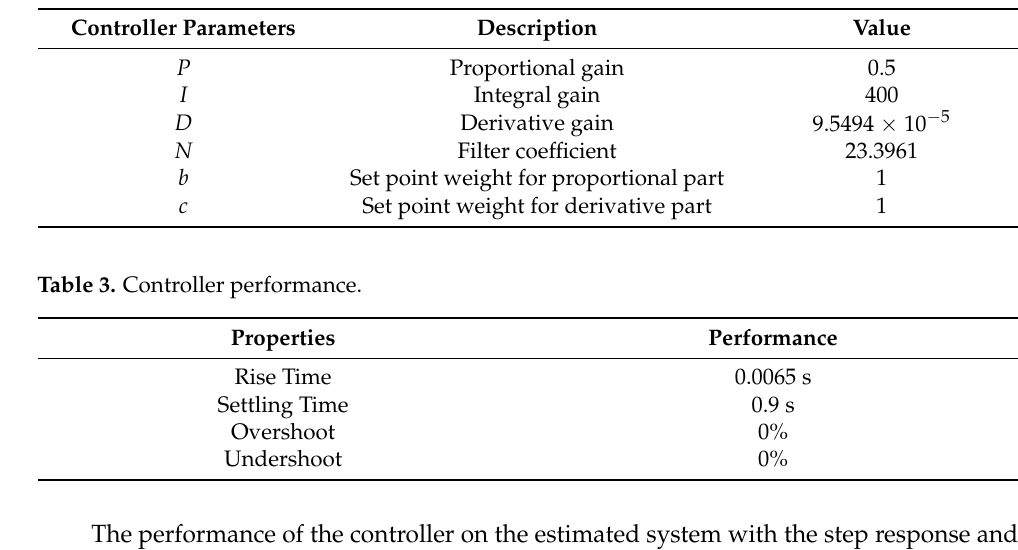
Table 2. Controller parameters.